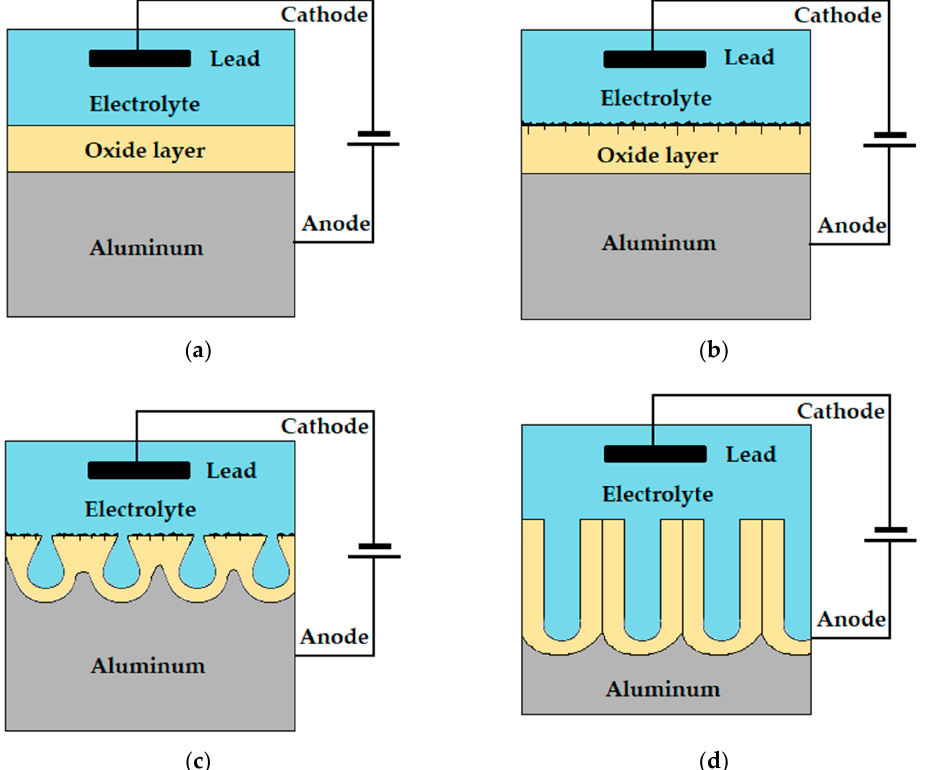
Figure 3. The steps in the formation of an oxide layer during DC anodizing: ( a ) barrier layer formation, ( b ) propagation of disturbances in the oxide layer (microcracks), ( c ) pore formation process, ( d ) growth of the oxide layer along with the deepening of the pores.